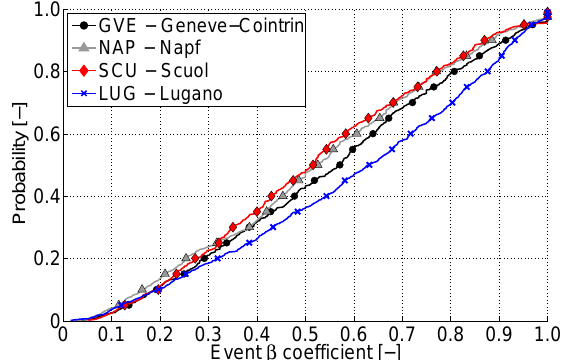
Fig. 9. Cumulative distributions (non-exceedance probability) of event β coefficients for all the storms with I p ≥ I ∗ (i.e., β > 0), for the studied stations.